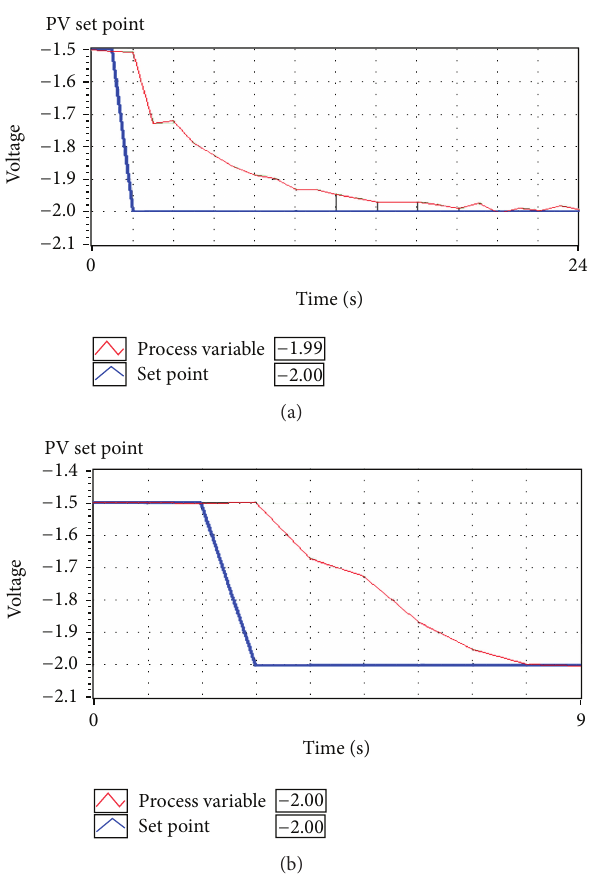
Figure 9: (a) Performance of PI controller (when set point changed from − 1.5 to − 2.0Volts) 𝐾 𝑝 = 0.2 , integral Time 𝑇 𝑖 ( Min ) = 0.18 . (b) Fuzzy controllers step response − 1.5 V to −